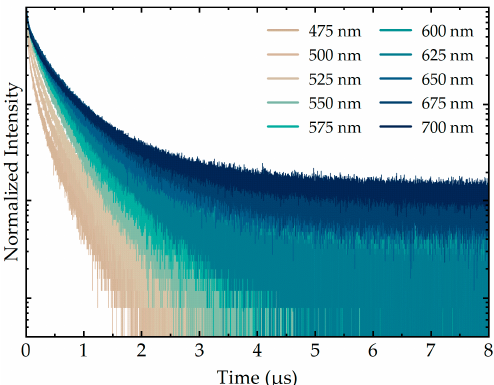
Figure 3. Normalized PL decay curves of the free AIS / ZAIS / ZnS quantum dots measured along the QD emission band with a 10 nm bandpass filter.